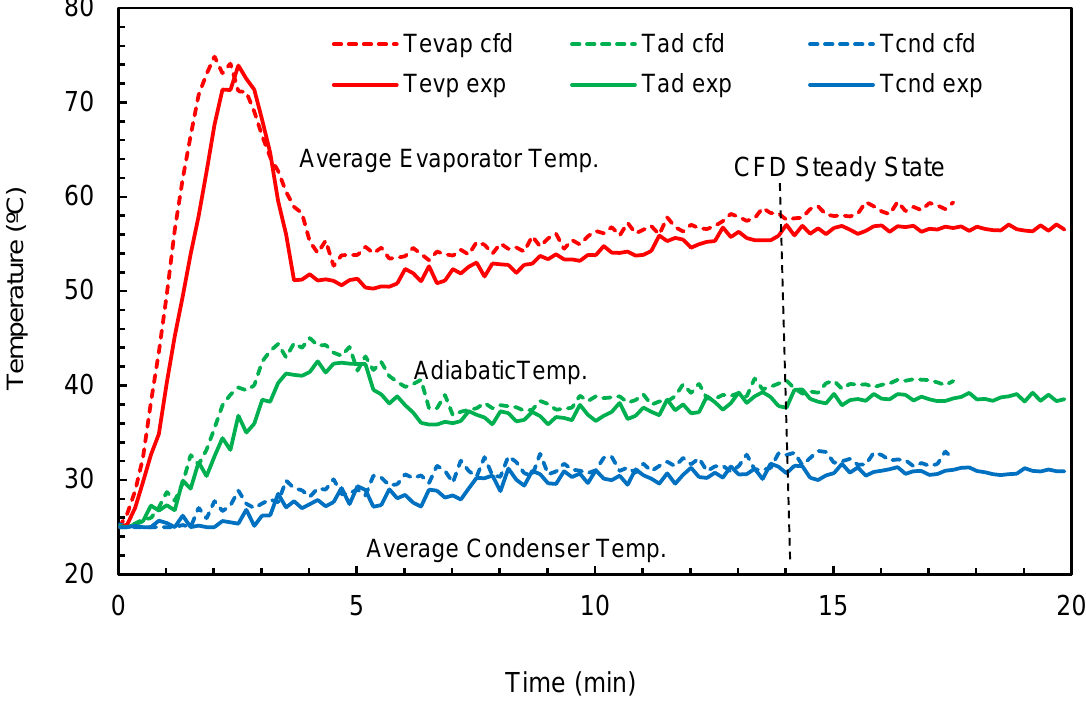
Figure 6. The evolution of temperatures of transient heat transfer for the THP (filling ratio = 50%, inclination angle = 45° and input power = 200 W).